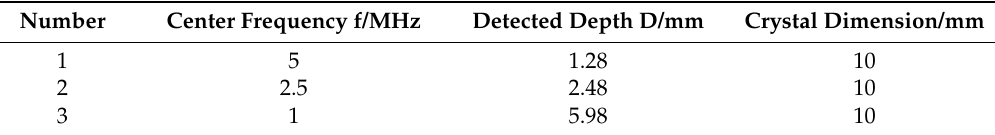
Table 2. Measurement parameters of the different frequency transducers.